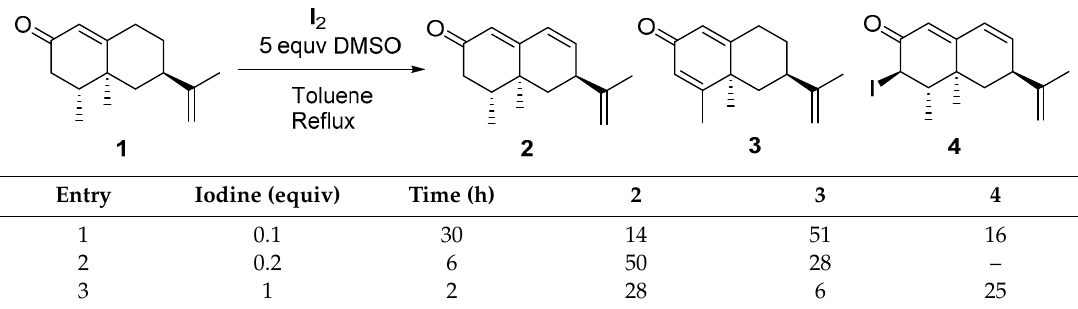
Table 1. Reaction of nootkatone with the dehydrogenating system I 2 / DMSO.